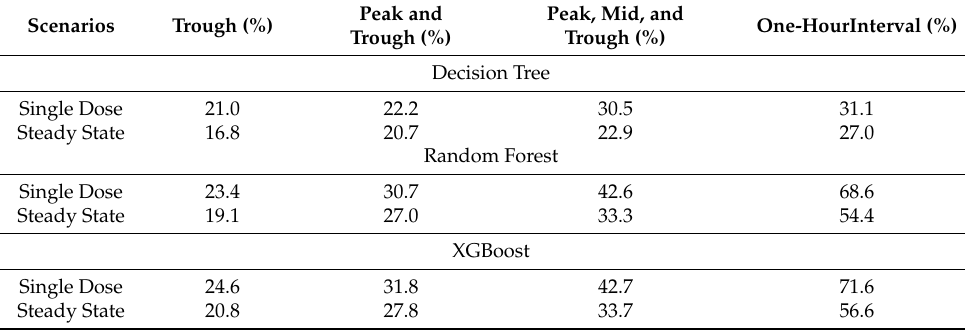
Table 1. The accuracy of the ML models in each